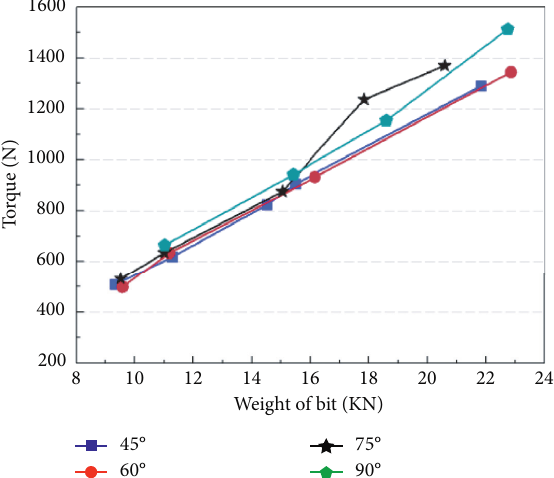
Figure 31: Relationship between WOB and torque with α change of bits (limestone).